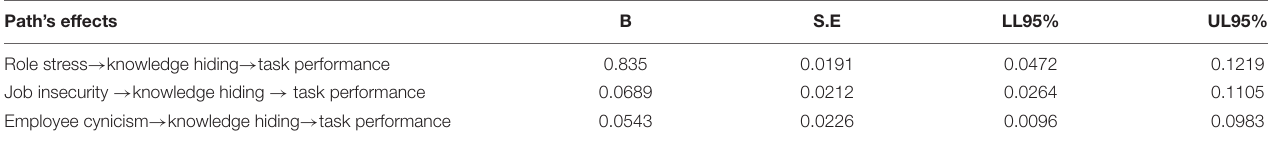
TABLE 5 | Moderation analysis.